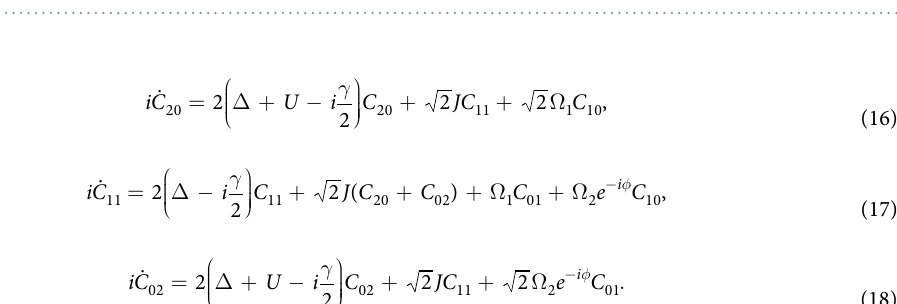
(2) , and ( b ) effect of environmental Figure 7. ( a ) Second-order correlation function with finite time-delay τ g ( ) b (2) for ζ (2) , and ( d ) temperature on g (0) + , φ + . ( c ) Second-order correlation function with finite time-delay τ g ( ) b b (2) for ζ effect of environmental temperature on g (0) − , φ − . Other parameters are considered to be same as in b Fig. 6(c,d). The dashed black lines correspond